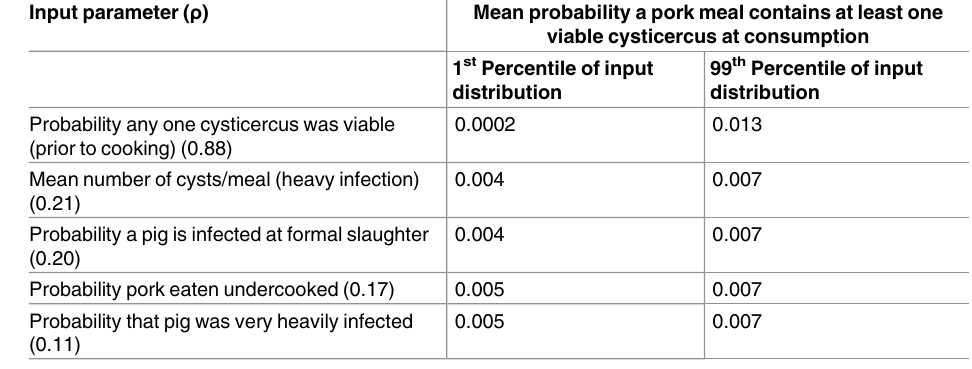
viable cysticercus at consumption 1 st Percentile of input 99 th Percentile of input distribution distribution 0.0002 0.013 0.004 0.007 0.004 0.007